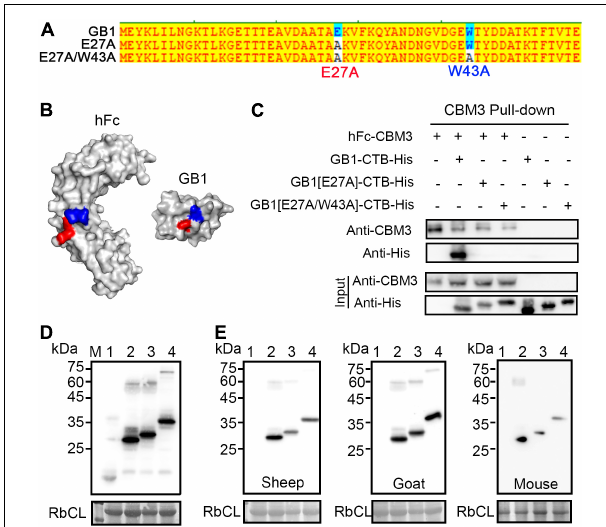
FIGURE 6 | GB1 is directly detected by IgG from various animals. (A) Protein sequences of GB1, GB1[E27A], and GB1[E27A/W43A]. Asterisks indicate mutations. (B) The 3-D structures of human Fc and GB1. These structures were obtained from the public database. Human Fc, PBD: 1aj7; GB1, PBD: 2gi9. The red color at the GB1 structure indicates E27, which functions as a knob for the hole of Fc (H433 and N434, red); the blue color at the GB1 structure indicates W43, which functions as a hole for the knob of Fc (I253 and S254, blue). (C) Strong binding of hFc to GB1 but not GB1 mutants. The indicated constructs were expressed in Nicotiana benthamiana , and total protein extracts were subjected to MCC beads-based protein pull-down. The proteins bound to the MCC beads were analyzed by western blotting using anti-CBM3 and anti-His antibodies. (D) Western blot analysis. Total protein extracts from N . benthamiana expressing the indicated constructs were analyzed by western blotting using the anti-His antibody. RbcL stained with CBB was used as a loading control. (E) Binding of various IgGs to GB1. Protein extracts used in Figure (D) were separated by SDS-PAGE and analyzed by western blotting using sheep anti-Mouse IgG (Sheep), goat anti-Human IgG (Goat), and mouse anti-Goat IgG (Mouse) without primary anti-His antibody. CTB, lane 1; GB1-CTB, lane 2; GB1[E27A]-CTB, lane 3; GB1[W43A]-CTB, lane 4. All constructs contain a His-tag at the C-terminus but are omitted to simplify the